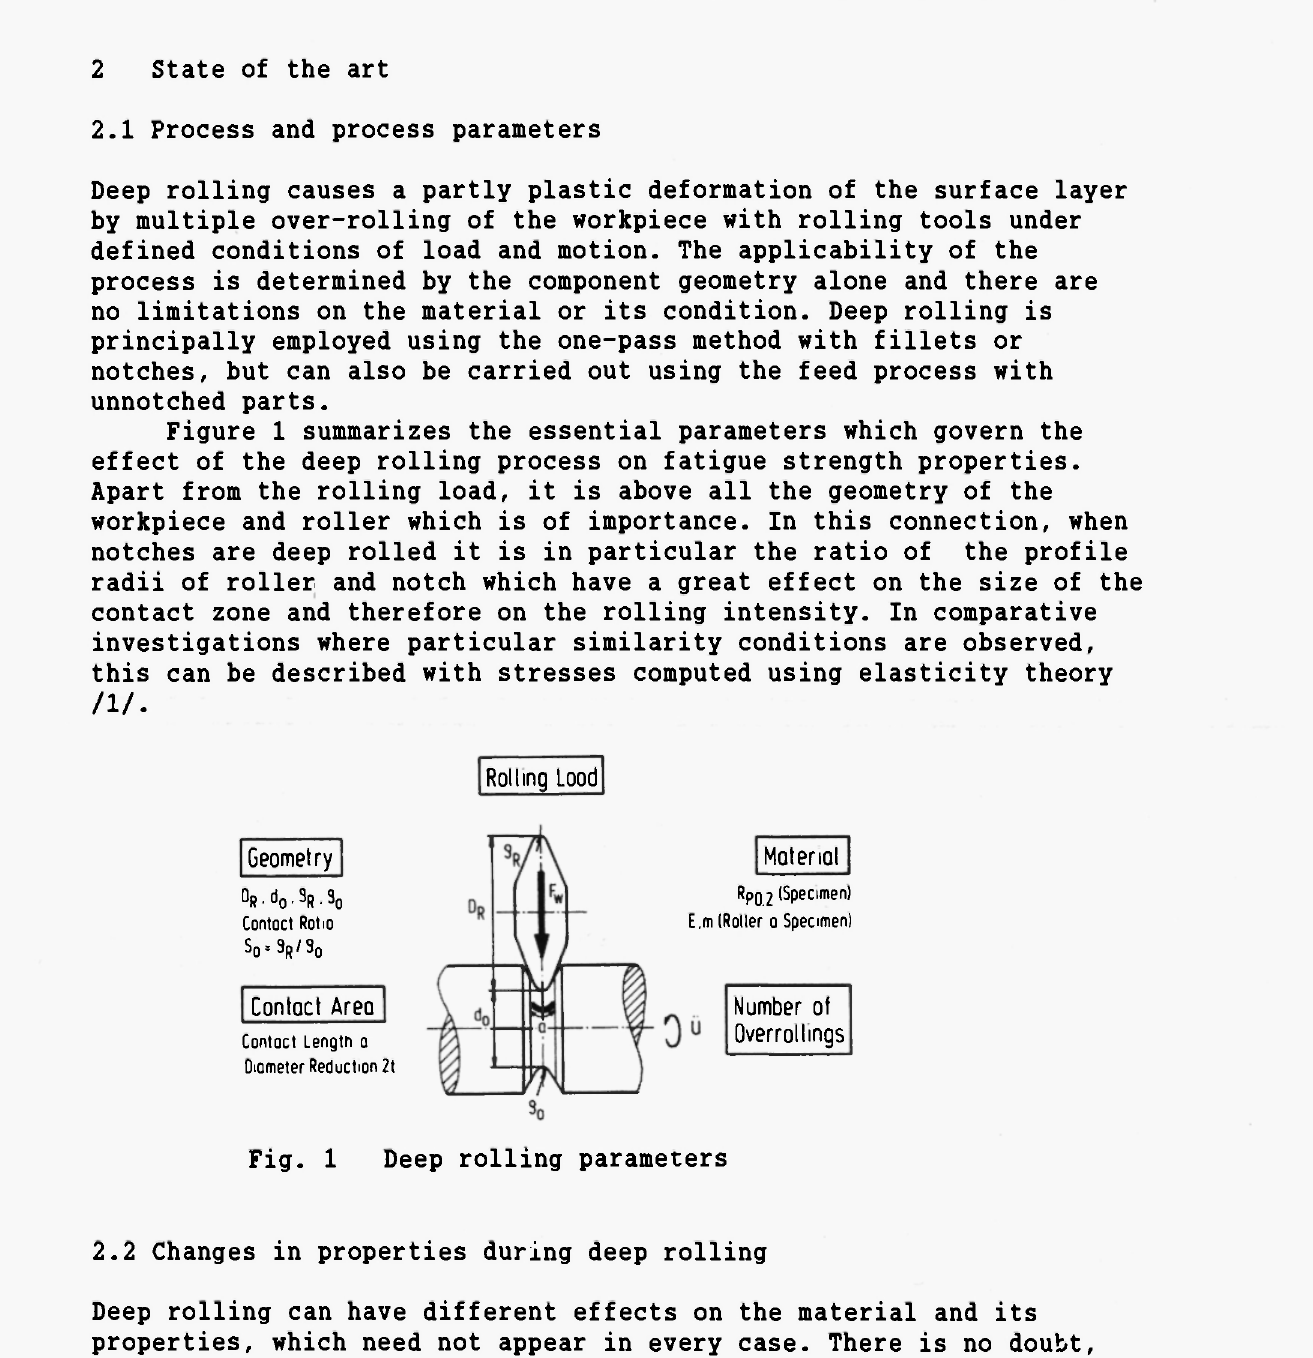
Fig. 1 Deep rolling